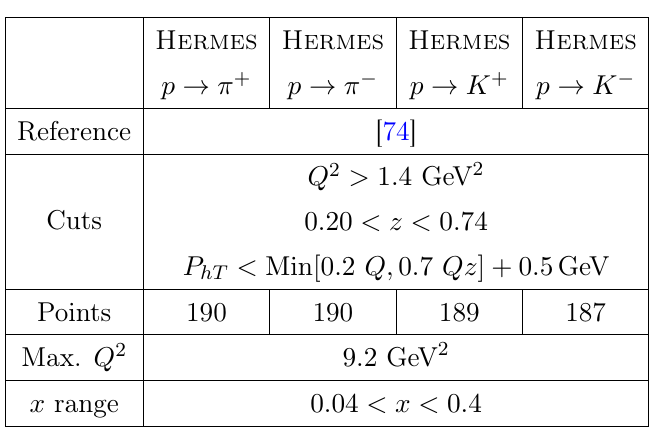
Table 1 . SIDIS proton-target data ( Hermes experiment).